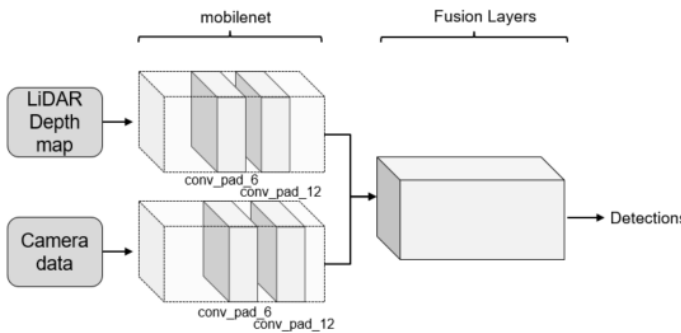
Figure 2. Proposed Multi-Level Sensor Fusion network structure for target